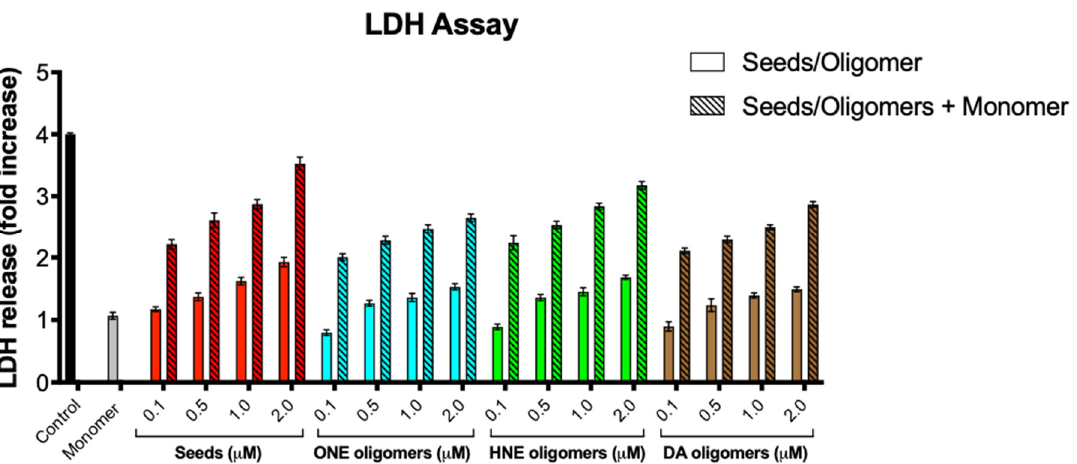
Figure 6. Toxicity of oligomers. LDH assay for cell apoptosis in SHY-5Y cells shows the presence of different concentrations (as indicated) of α-syn DA, HNE, and ONE oligomers incubated alone (solid bars) or in combination with 10 μM of α-syn monomers (dashed bars) after 48 h incubation.